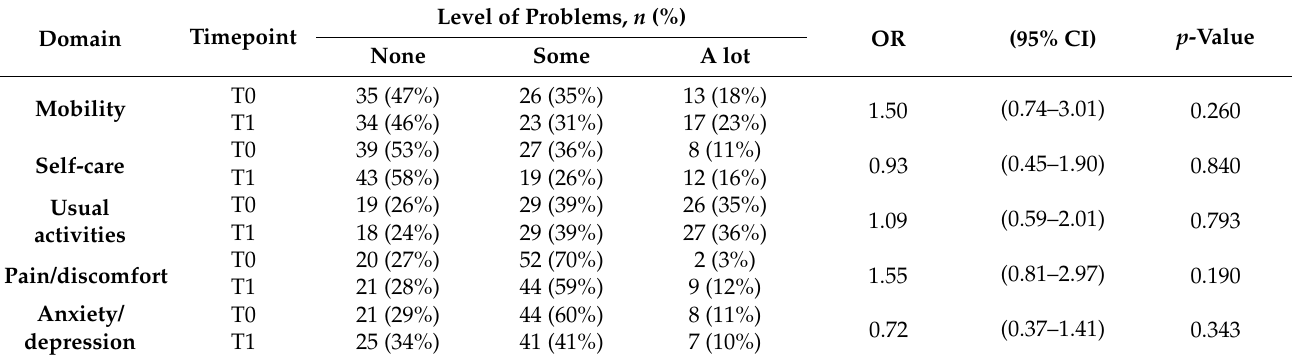
Table 5. Change between T0 and T1 in parent-proxy QoL reports on EQ-5D-Y domains *.